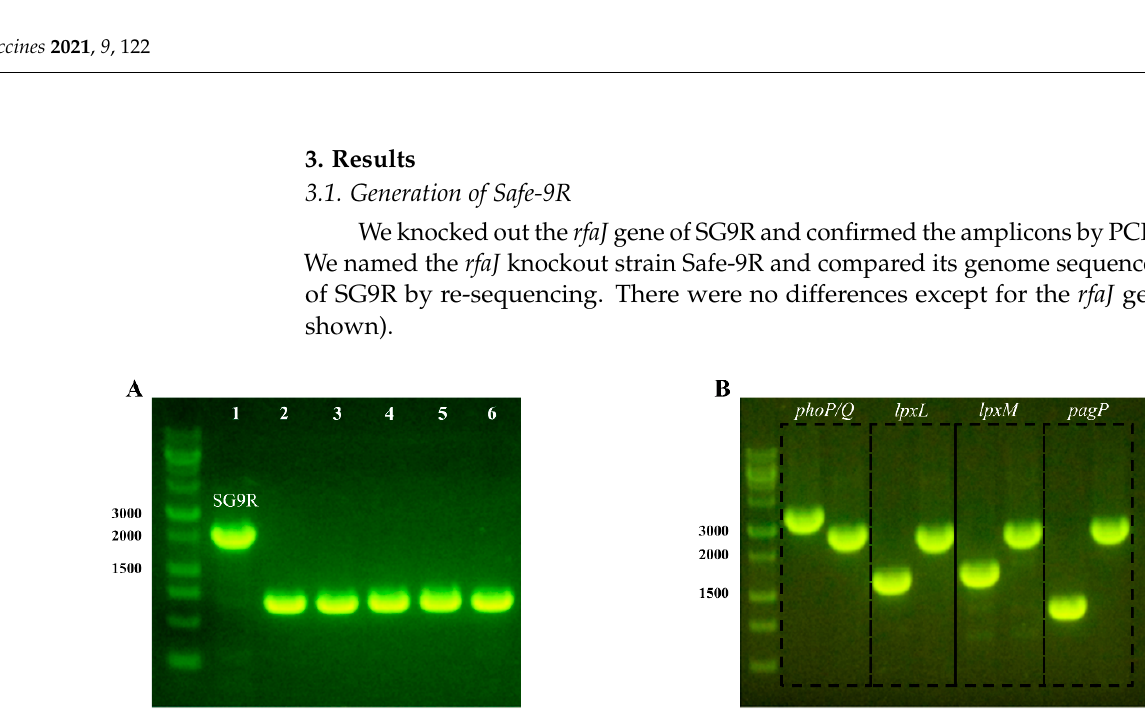
Figure 1. Deletion of rfaJ in Safe-9R and detoxified strains. ( A ) Deletion of rfaJ in Safe-9R and Safe-9R-derived knock-out strains. Lanes: 1, SG9R; 2, Safe-9R; 3, Δ phoP/Q ; 4, Δ lpxL ; 5, Δ lpxM ; 6, Δ pagP . ( B ) Deletion of lipid A biosynthesis-related genes of Safe-9R-derived knock-out strains. The amplicon of Safe-9R for each gene was placed at the first lane of each rectangle to compare the amplicon of knock-out mutant strain.